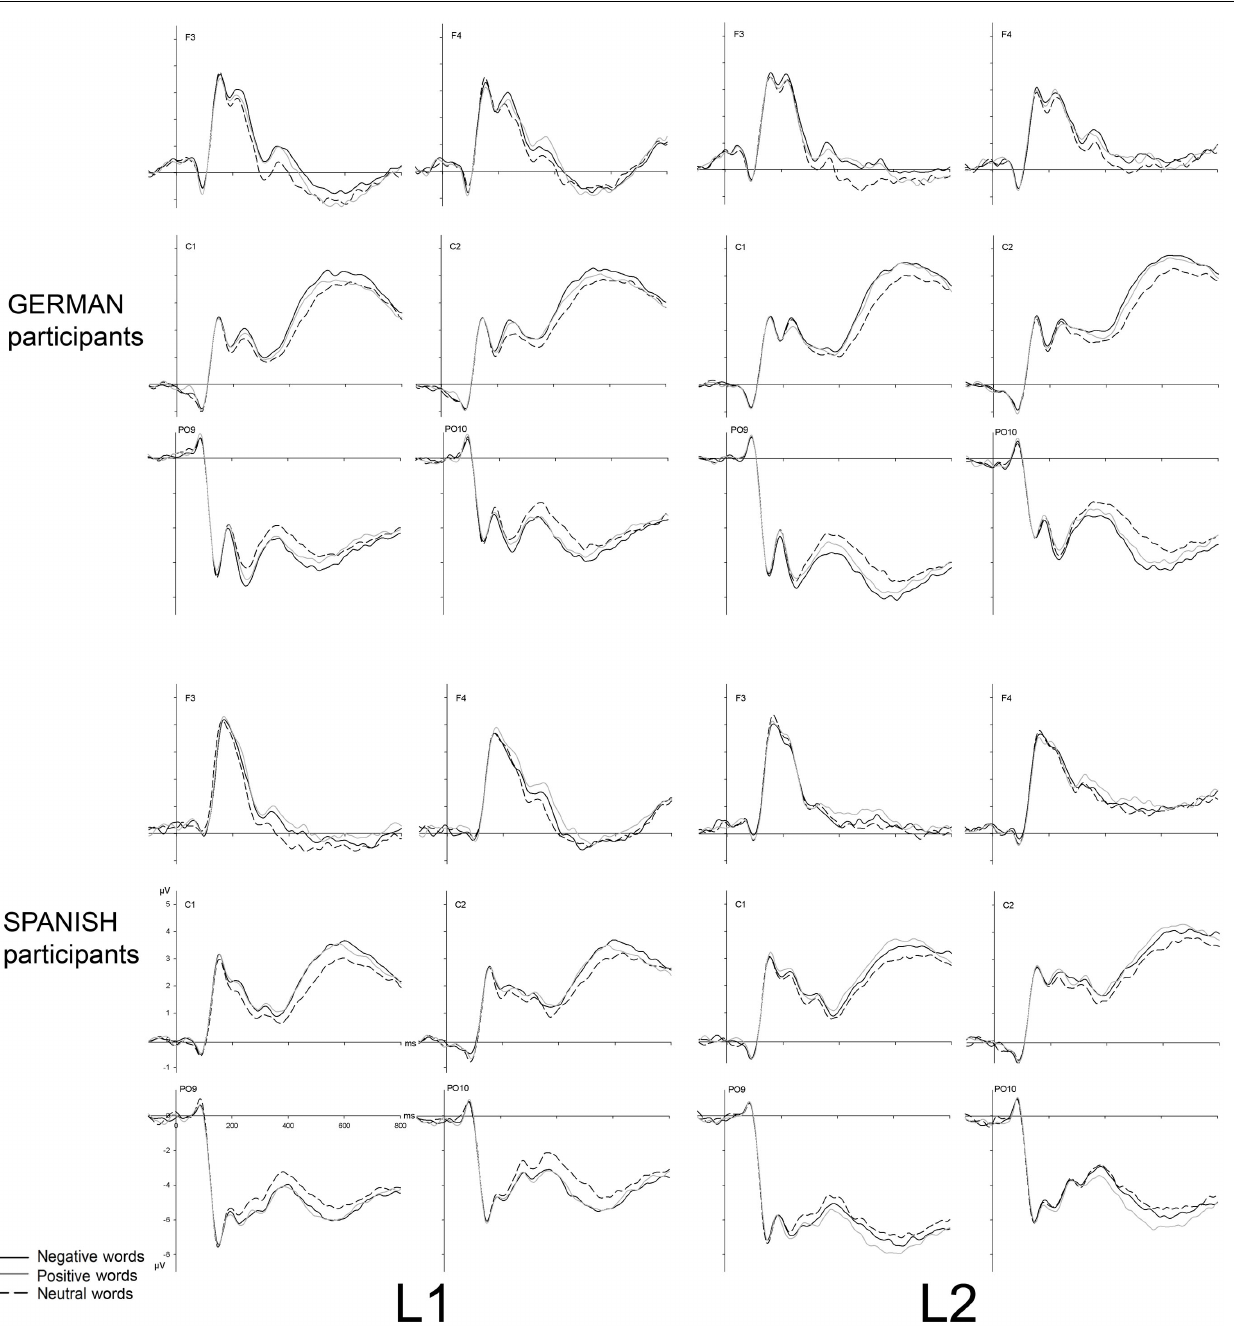
the L2 data for German participants was 50 ms later as compared to L1 (in the respective analyses involving valence as three levels factor). Figure 4 represents this latency shift superimposing differ- ence waves for respective valence effects (positive – neutral words) in L1 and L2 for the 40 German participants at an electrode site representative for the EPN